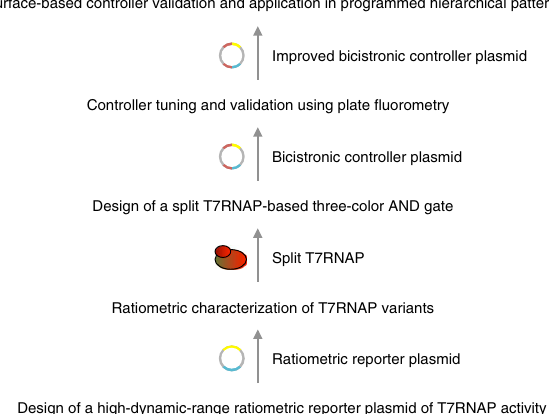
Fig. 1 Design work fl ow of a genetic circuit for synthetic hierarchical patterning. The resulting synthetic circuit autonomously mediates the programmed emergence of a gene expression domain at the interface of two bacterial